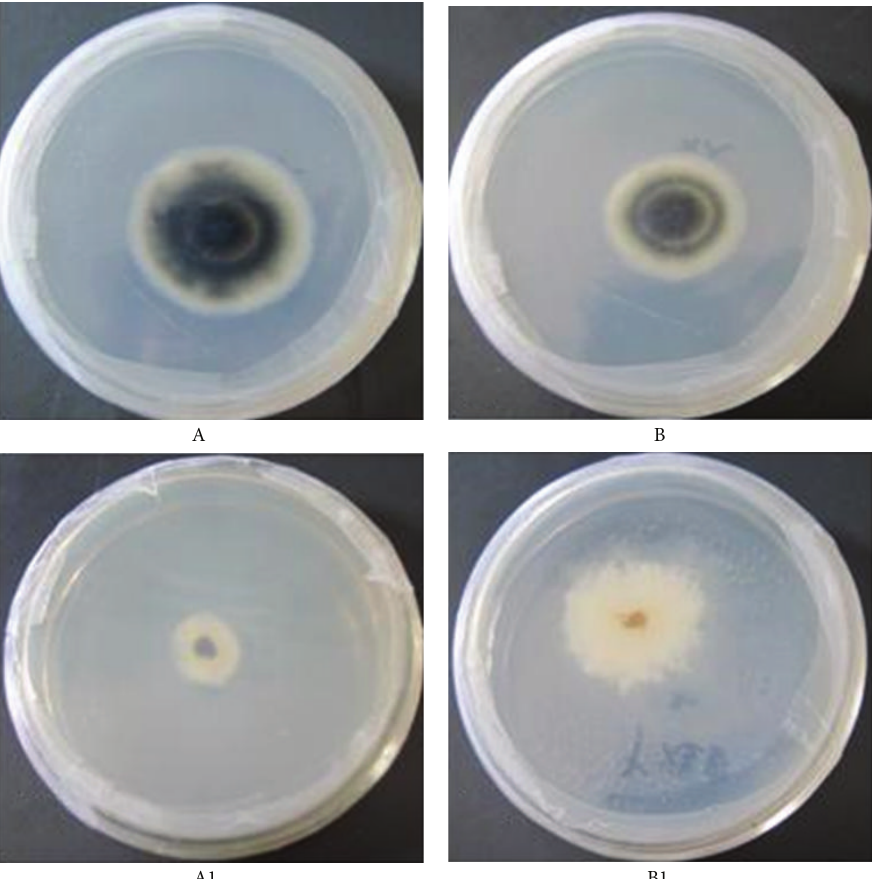
Figure 6: Inhibition of recombinant exrCHI31 (A) and exrCHI32 (B) to A. alternate . (A) The mycelia of A. alternate grown on PDA medium for 7 d (control); (A1). The mycelia of A. alternate grown on PDA medium containing exrCHI31 for 7d; (B). The mycelia of A. alternate grown on PDA medium for 5d (control); (B1). The mycelia of A. alternate grown on PDA medium containing exrCHI32 for 5